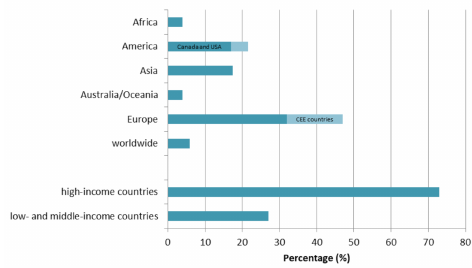
Figure 2. Reviewed studies according to the spatial focus/territories of research.